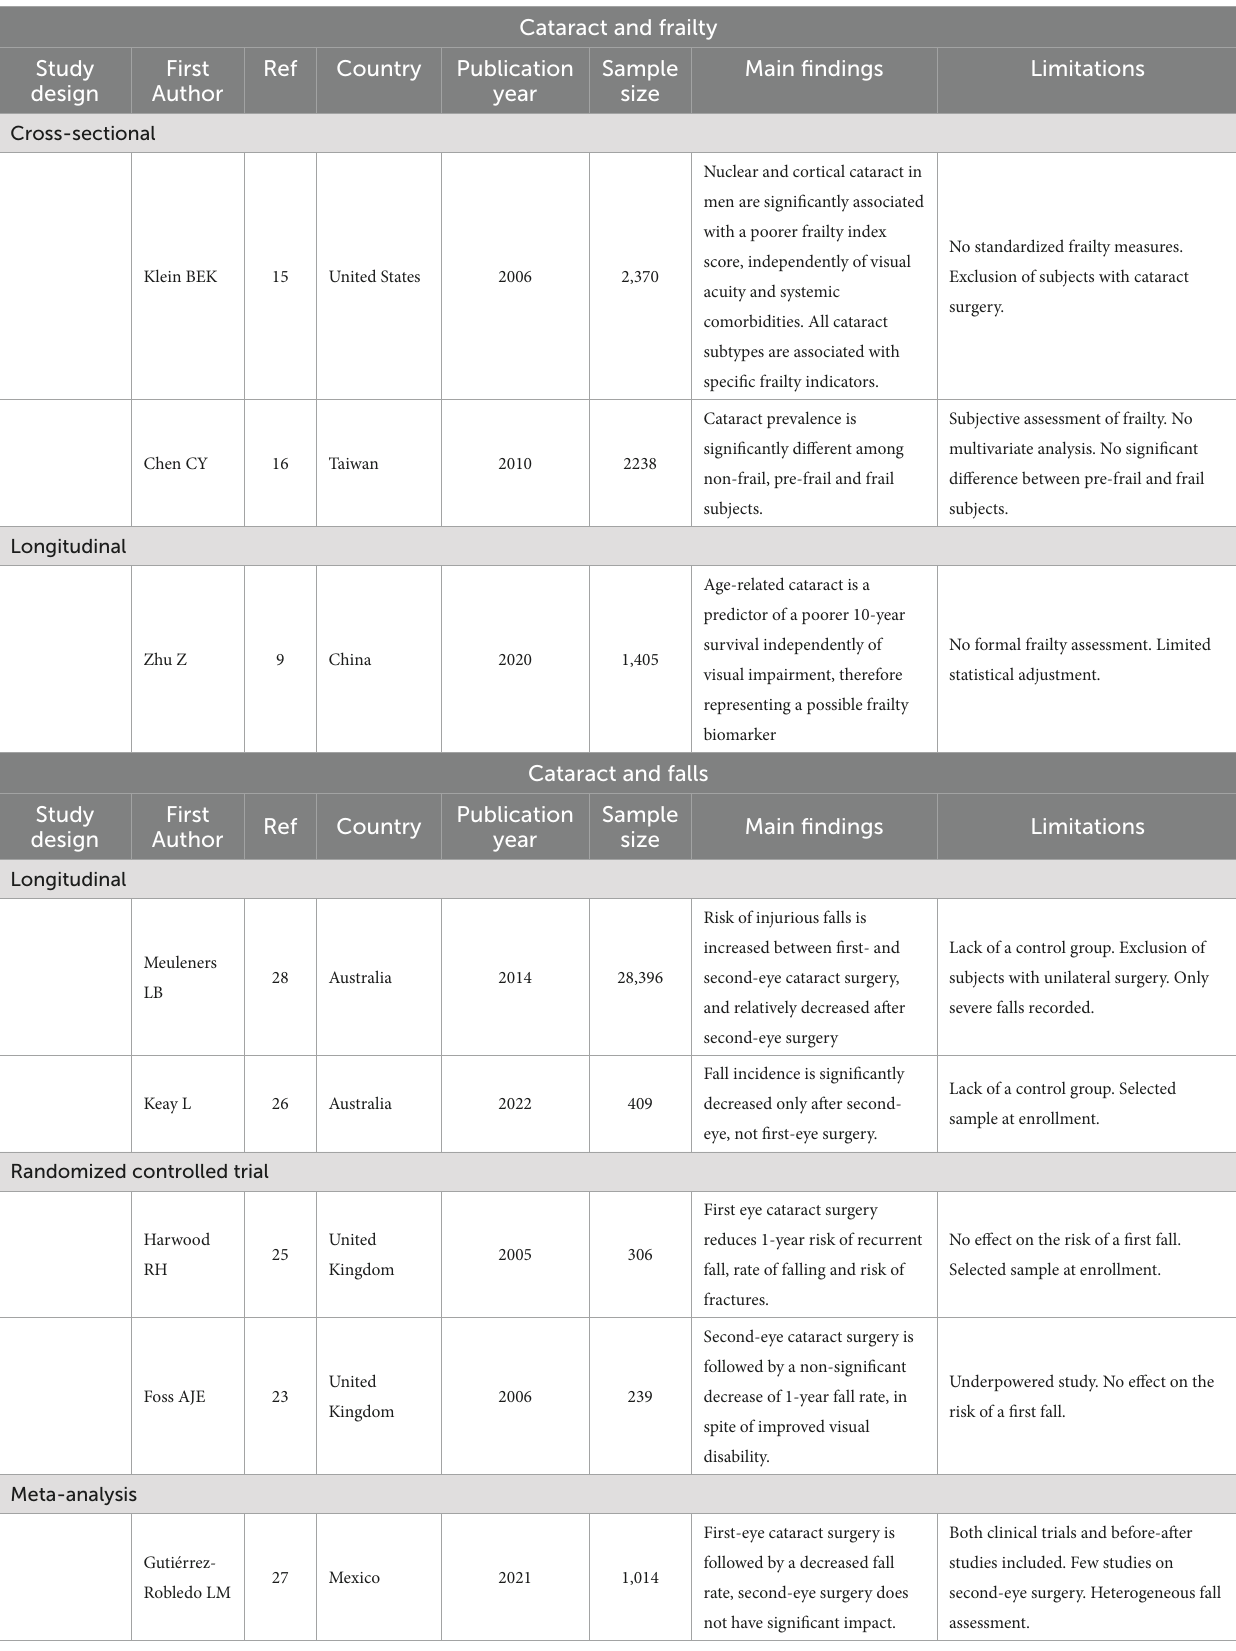
TABLE 1 Summary of the studies regarding age-related cataract and main health